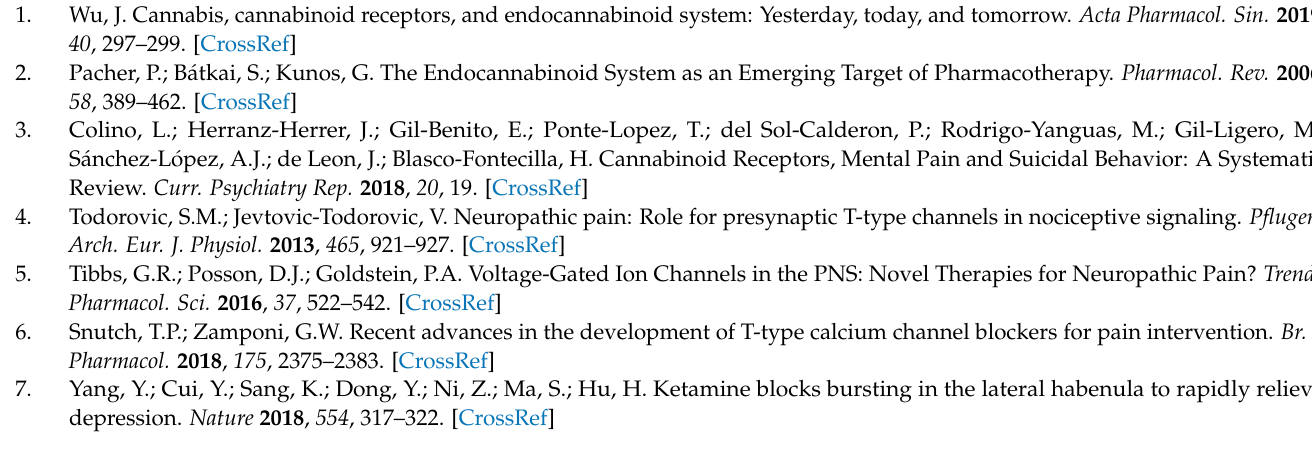
Supplementary Materials: The following are available online. Table S1: experimental and calculated 1 H NMR δ (ppm) at BP86/cc-pVTZ level of theory in chloroform for NMP compounds; Table S2: Experimental and calculated 13 C NMR δ (ppm) at BP86/cc-pVTZ level of theory in chloroform for NMP compounds; Table S3: theoretical IR frequencies (in cm − 1 ) and PED ( ≥ 10%) at BP86/cc-pVTZ level of theory in chloroform for NMP compounds using the scale factor of 1.014. ν refers to stretching vibrational mode, β refers to in plane bending vibrational mode, and τ refers to torsional vibrational mode; Table S4: selected bond lengths (Å), valence angles and dihedral angles (degrees) for the NMP compounds at BP86/cc-pVTZ level of theory in chloroform solvent; Table S5: molecular orbital Table S6: NBO analysis (donor → acceptor) for NMP compounds at BP86/cc-pVTZ level of theory in chloroform; Table S7: Fukui functions, f + ( r ) and f − ( r ) , dual descriptor, f ( 2 ) ( r ) , and Parr functions, P − ( r ) and P + ( r ) , for the NMP compounds at BP86/cc-pVTZ level of theory in chloroform; Figure S1: correlation graph ∆ E gap values (in eV) with the experimental logIC 50 values (in µ M) for the NMP compounds obtained at BP86/cc-pVTZ level of theory in chloroform solvent; Figure S2: ( A ) diagram of the structure Ca v 3.2 channel, in color code represented the four domains: the domain I (DI) in blue, the domain II (DII) in green, the domain III (DIII) in beige, and the domain IV (DIV) in red. Each domain contains six transmembrane segments (S1–S6). The segments S1–S4 form the voltage-sensing domain (VSD) and the segments S5–S6 with the segment P (P1 and P2) form the pore domain (PD). ( B ) Lateral view of the human Ca v 3.2 channel generated by homology modeling, the extracellular (EC), transmembrane (TM) and intracellular (IC) portion are indicated. ( C ) Extracellular view of the human Ca v 3.2 channel. ( D ) Extracellular view diagram of the spatial distribution of the transmembrane segments of the human Ca v 3.2